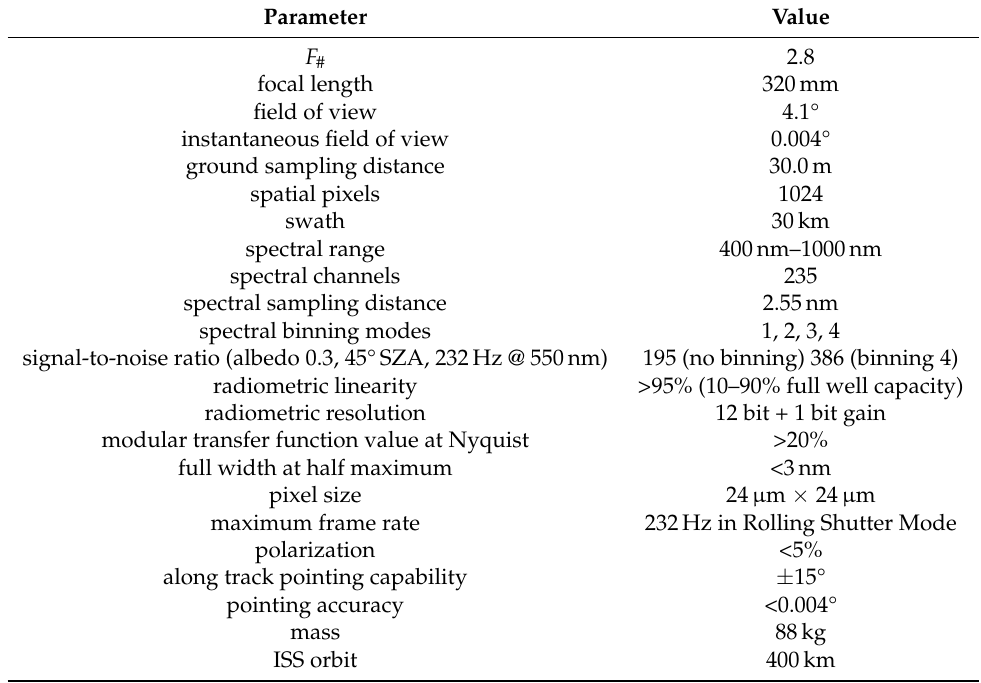
Table 1. German Aerospace Center (DLR) Earth Sensing Imaging Spectrometer (DESIS)